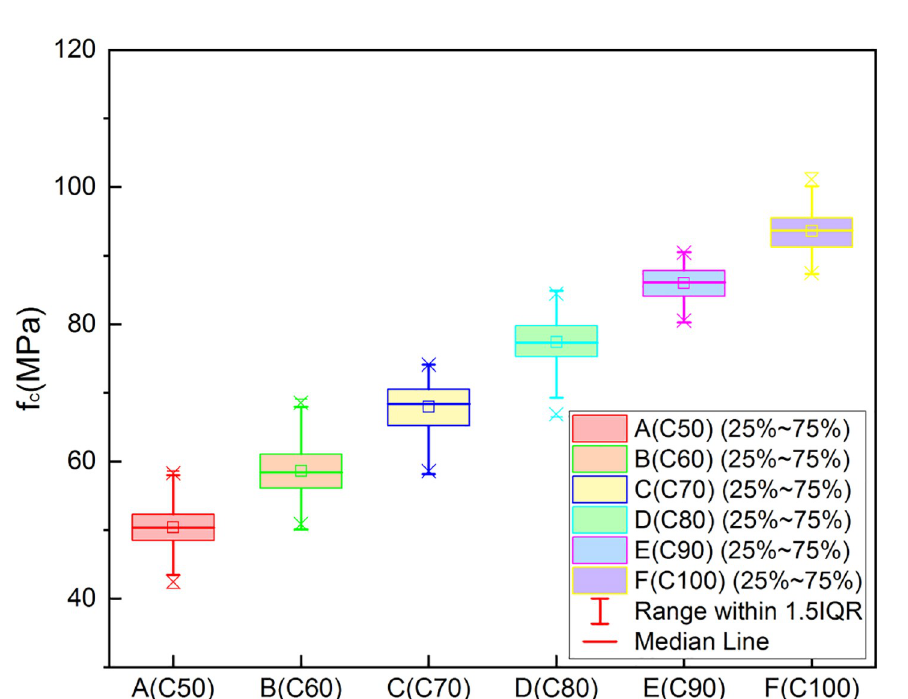
Fig 8. Boxplot of experimental data (fc).